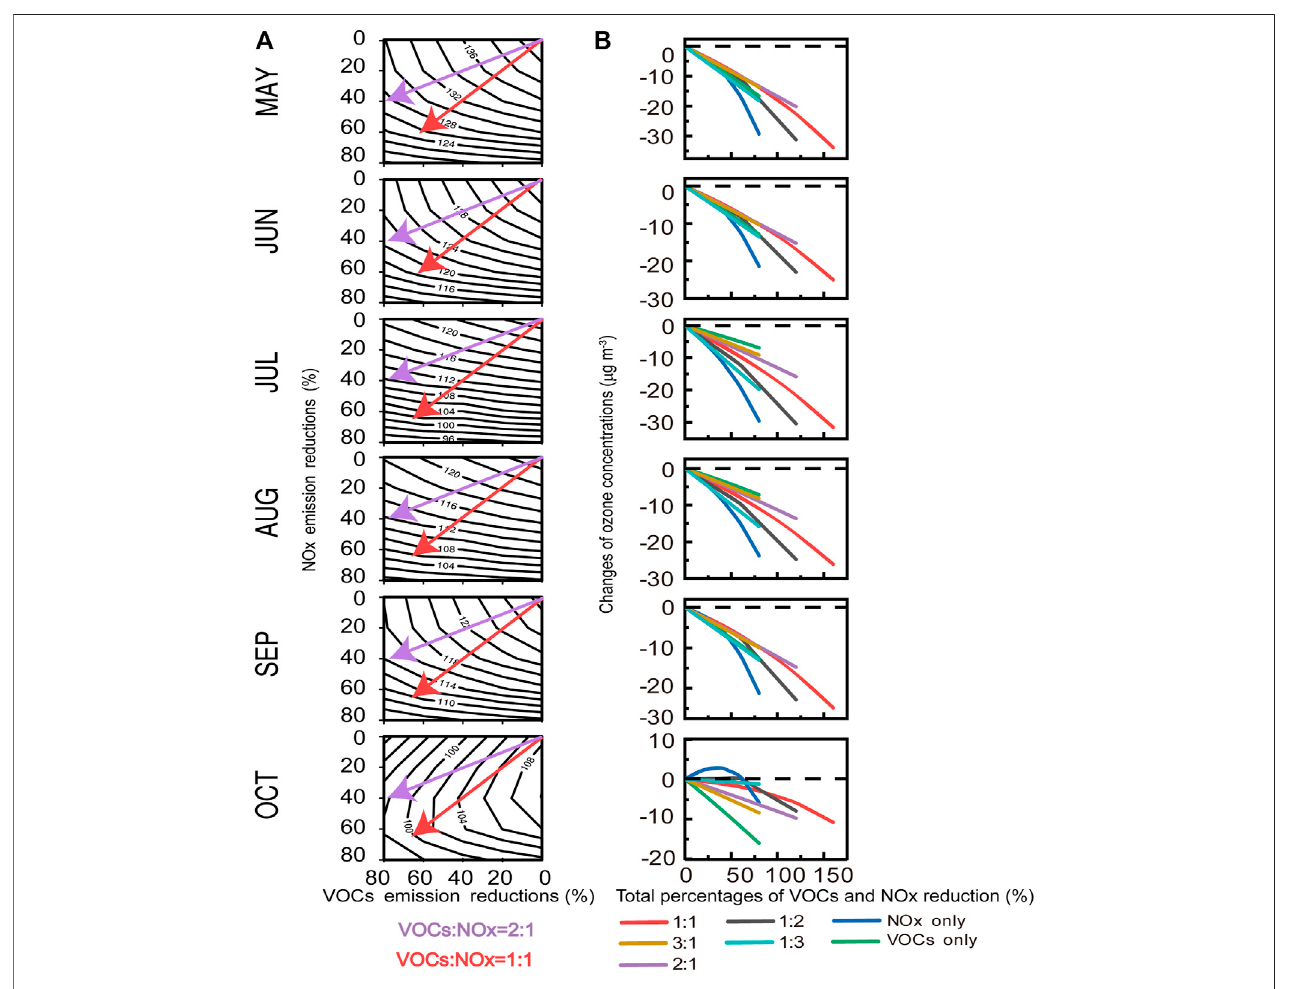
FIGURE 6 | Same as Figure 4 , but for